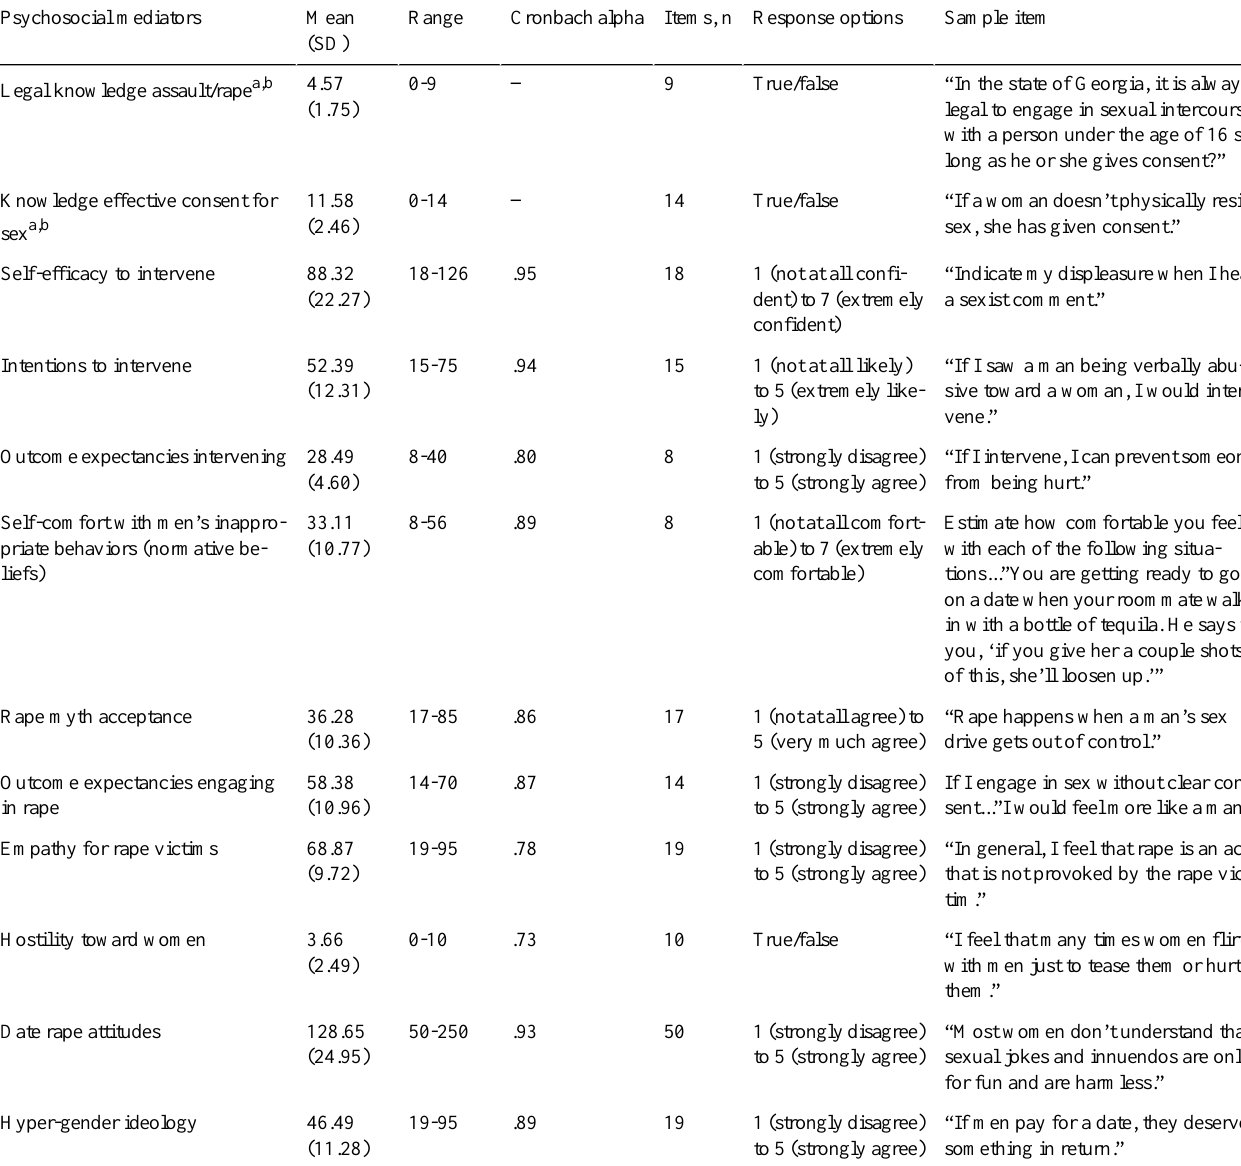
Table 1. Description of secondary outcomes/psychosocial mediators and means (SD) at